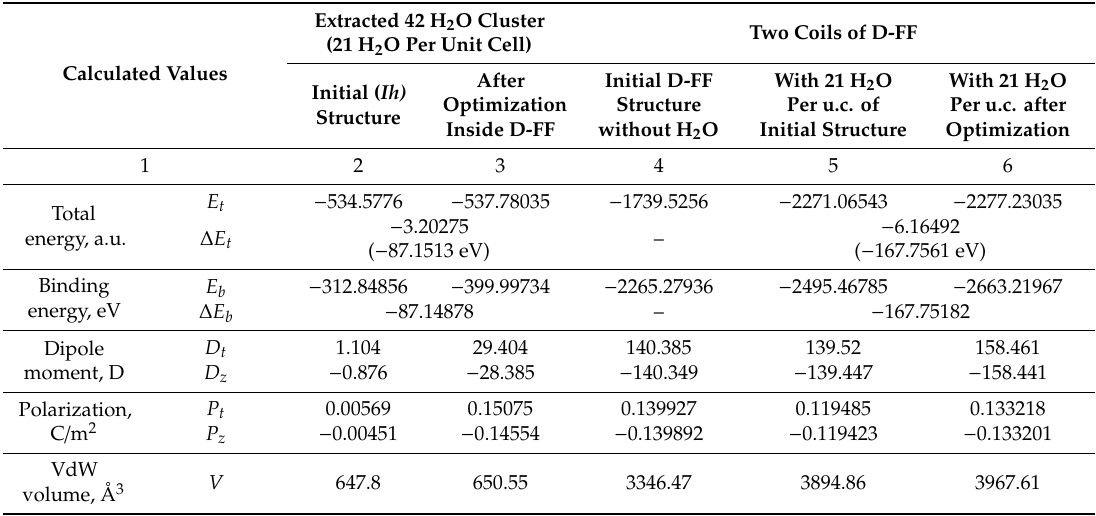
Table 3. Energy, dipole moment and polarization of D-FF PNTs and water clusters, computed using